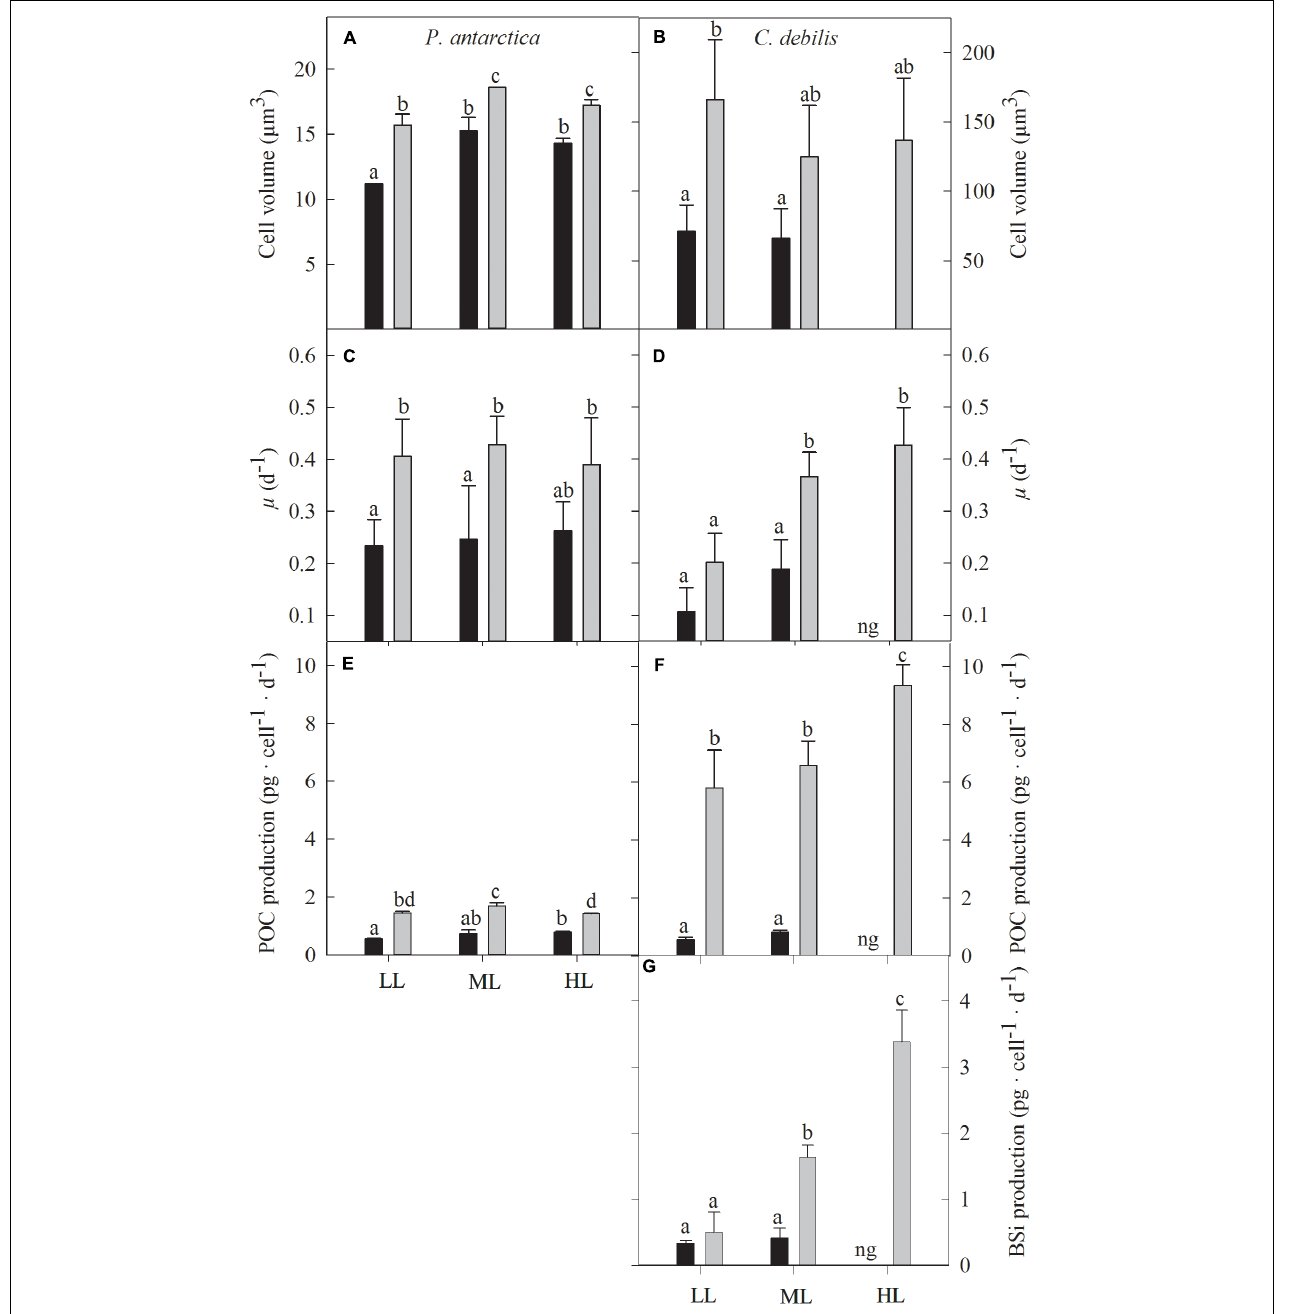
FIGURE 2 | Cell volume (A,B) , growth rate (C,D) , cellular production rate of particulate organic carbon (E,F) and biogenic silica (G) for P. antarctica (A,C,E) and C. debilis (B,D,F,G) acclimated to control (black bars) or Fe-enriched (gray bars) conditions combined with low (LL), medium (ML) or high light (HL). C. debilis did not grow in control HL treatments as indicated by ng. Values represent the means ± SD ( n = 3). Different letters indicate significant differences between treatments ( p <